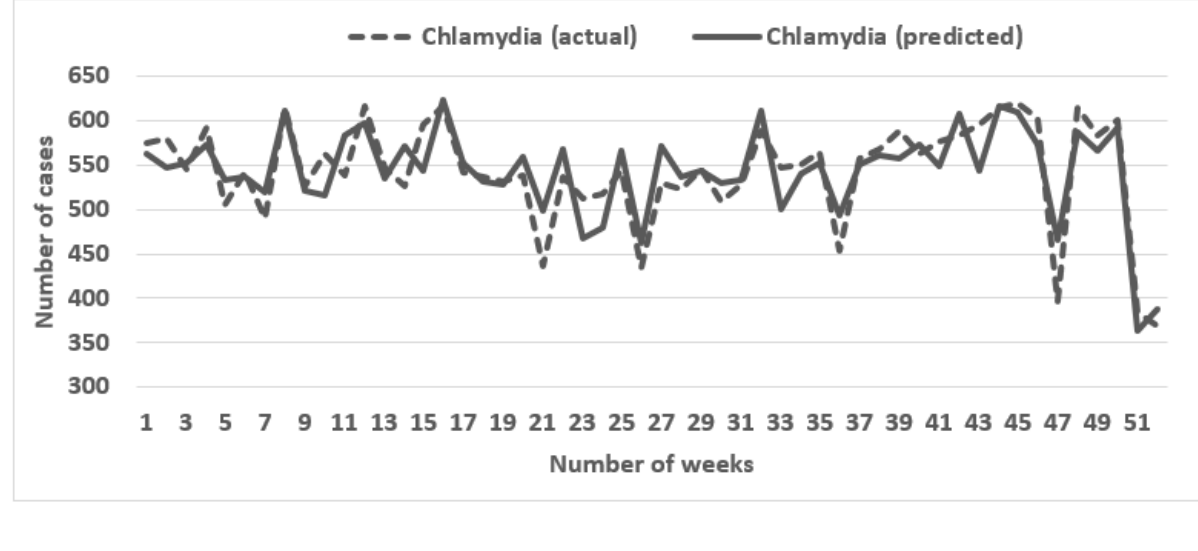
Figure 3. Graphical comparison between the actual and predicted number of syphilis cases for